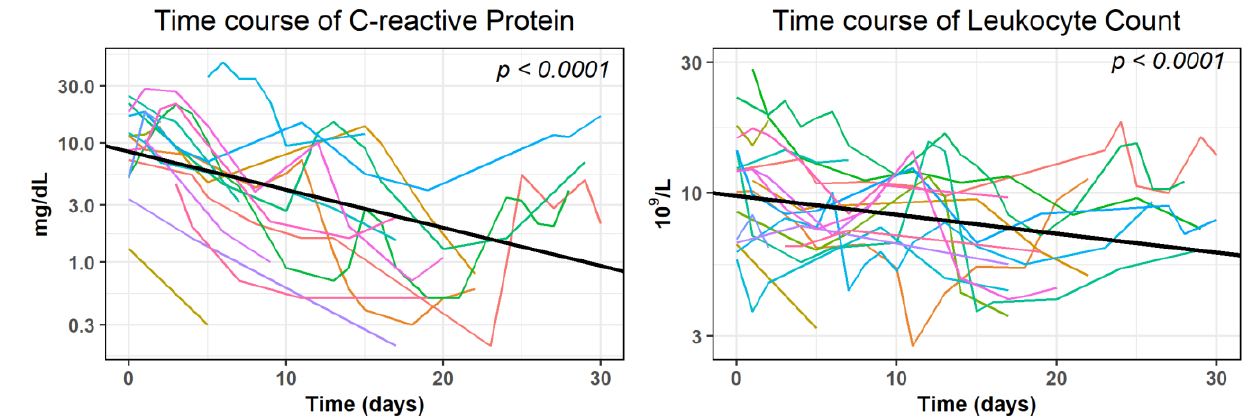
Figure 5. Development of laboratory parameters within 30 days after the intervention in subjects ( n = 19) with no evidence of further surgical interventions or complications in the patient record.